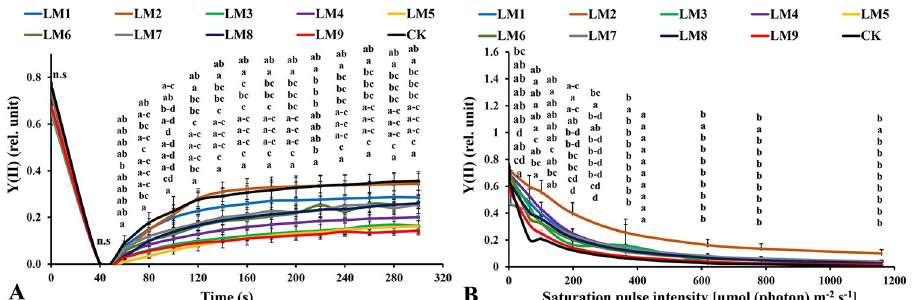
Fig 6. Effects of LED light modes on chlorophyll a fluorescence induction kinetics of the dark-acclimated (A) and RLC of the light-acclimated (B) of effective quantum yield of PSII photochemistry Y(II) in rocket leaves. The points are means ± SE of 4 replicates followed by the same letters meaning no different significantly according to the Duncan test (P � 0.05). Sort significance letters from top to bottom according to the treatments (ML1-CK). LM1 = A1:B1:C1, LM2 = A1:B2:C2, LM3 = A1:B3:C3, LM4 = A2:B1:C2, LM5 = A2:B2:C3, LM6 = A2:B3:C1, LM7 = A3:B1:C3, LM8 = A3:B2:C1, LM9 = A3:B3:C1, CK = White fluorescent light.